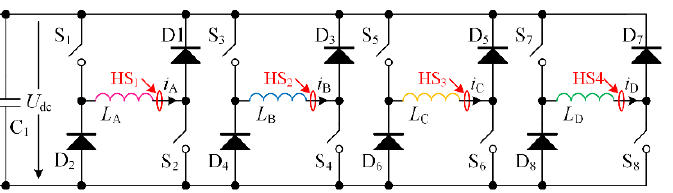
Figure 1. Asymmetric half-bridge converter (AHBC) with four hall effect current sensors for a four-phase 8/6 switched reluctance motor (SRM).